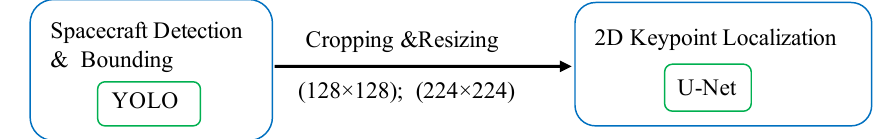
Figure 8. Detection, Cropping and Keypoint Localization Flow.